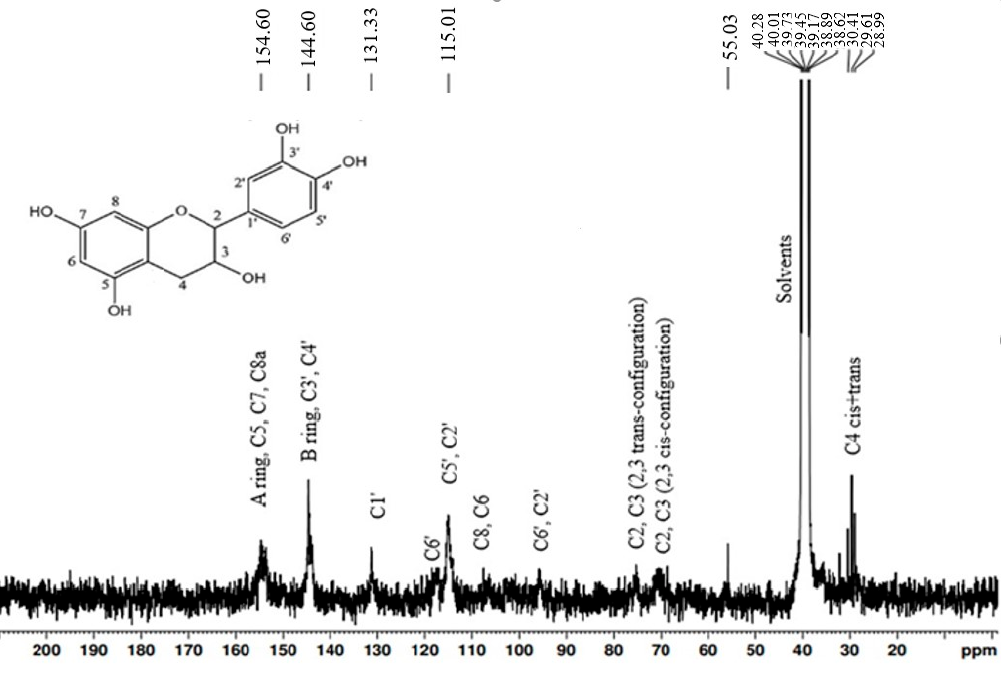
Figure 4. The 13 C-NMR spectrum of purified CTs from Alnus incana bark.